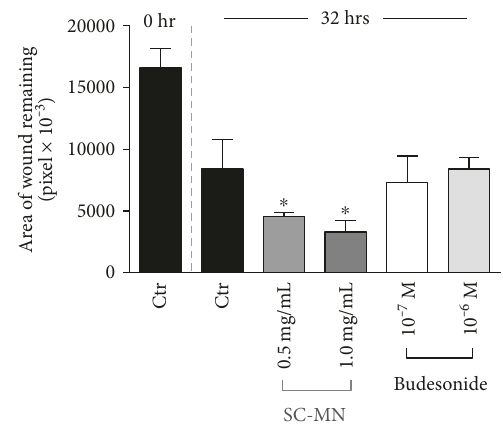
Figure 3: SC-MN ’ s bene fi cial e ff ect on mechanical wound closure in NHBEC. SC-MN at 0.5 and 1.0mg/ml concentration signi fi cantly facilitated wound closure compared to the control- (saline-) treated cultures. Budesonide had no such e ff ect. ∗ p < 0 05